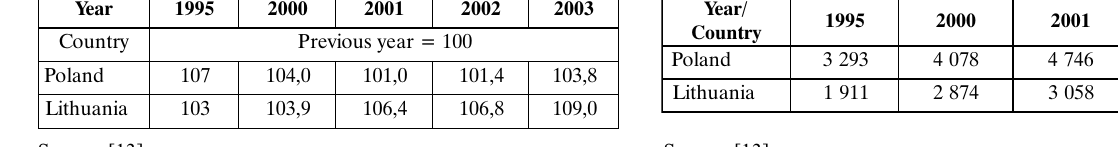
Table 4. Inflation rate in Poland and Lithuania, in